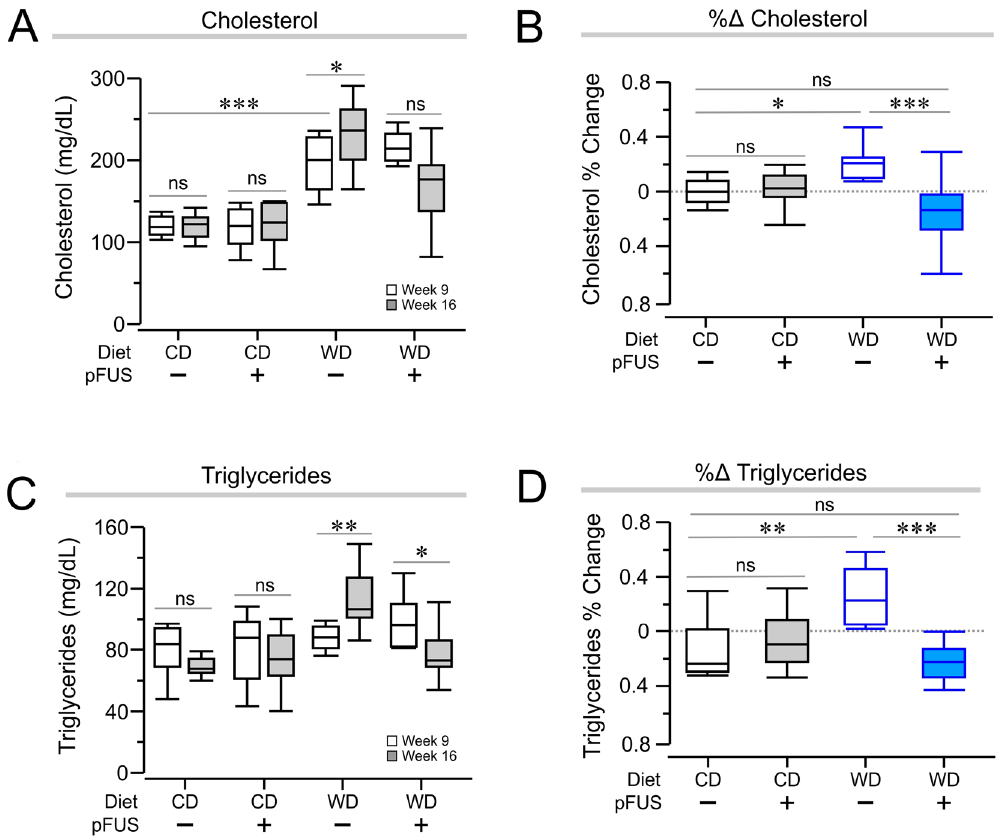
Figure 4. Hepatic pFUS attenuates levels of circulating lipids. ( A ) At week 9, Western diet–sham and Western diet–pFUS mice had significantly increased cholesterol levels when compared to the control diet–pFUS group. (*** P < 0.001, two-way ANOVA). Hepatic pFUS attenuates total cholesterol increase seen in Western diet–sham mice (WD–sham, week 9 vs week 16, * P < 0.05, two-way ANOVA). ( B ) Percent change of cholesterol levels between weeks 9 and 16 reveal that the Western diet–pFUS group has a percent decrease that is significantly different from the Western diet–sham group (*** P < 0.001, one-way ANOVA) ( C ) Hepatic pFUS lowers circulating triglyceride levels shown to increase in Western diet–sham mice (WD–sham, week 9 vs week 16, ** P < 0.01; WD–pFUS, week 9 vs week 16, * P < 0.05, two-way ANOVA). ( D ) Percent change of triglyceride levels between weeks 9 and 16 demonstrate that the Western diet–pFUS percent decrease is significantly different from the Western diet–sham percent increase (*** P < 0.001, one-way